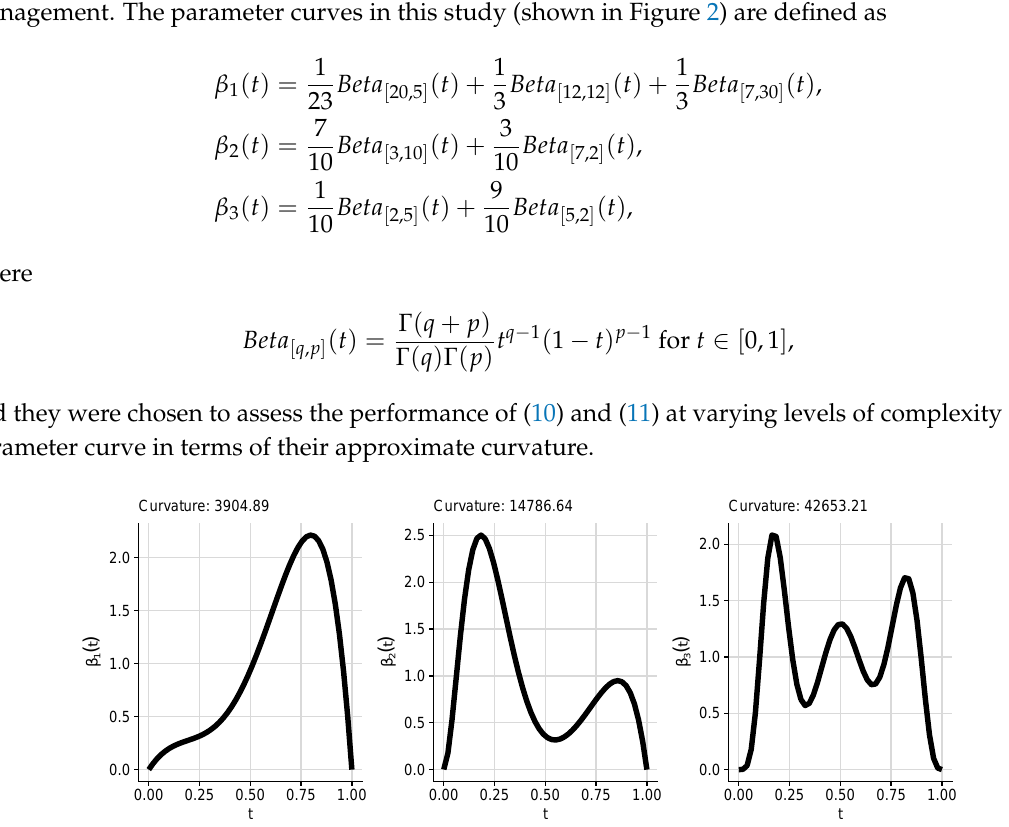
Figure 2. The parameter curves β 1 ( t ) ( left ), β 2 ( t ) ( middle ), and β 3 ( t ) ( right ) used in the simulation